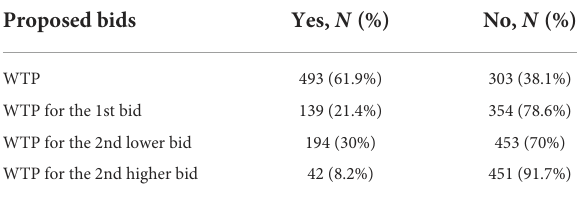
TABLE 5 Summary statistics to double-bounded dichotomous choice questions with 3% starting bid on the WTP for SHI at DCA, North-East Ethiopia ( n = 796), May 2021.